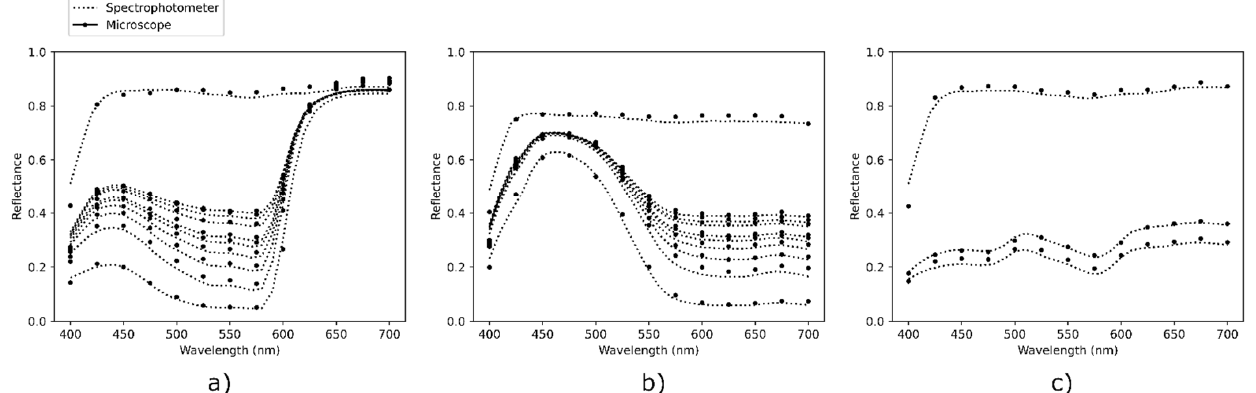
Figure 4. Average reflectance of the multispectral microscope images, compared with macroscale reflectance measurement with a spectrophotometer. ( a ) Magenta line halftones, ( b ) cyan line halftones, ( c ) multicolored dot halftones.